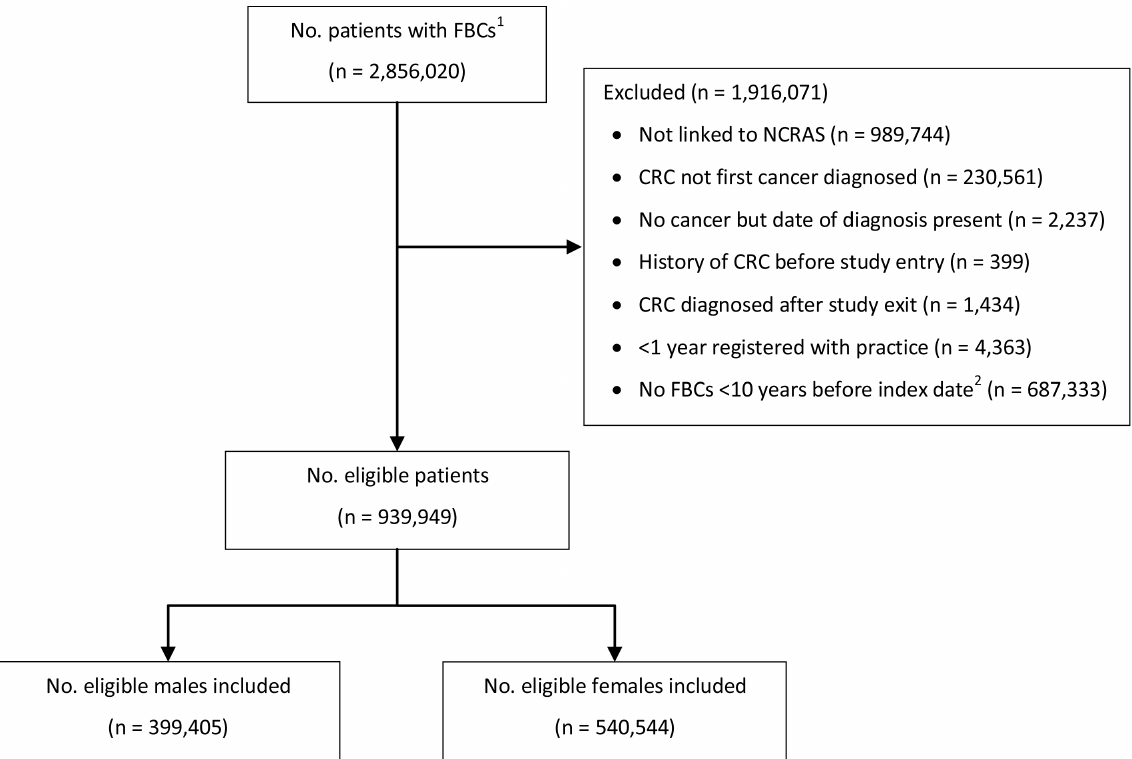
Figure 1. Patient flow chart. 1 Number of patients available in the CPRD data extract. 2 Index date was the date of diagnosis for cases and a randomly selected date in the patient’s study period for controls. Abbreviations: FBC = full blood count; CRC = colorectal cancer; NCRAS = National Cancer Registration and Analysis Service.